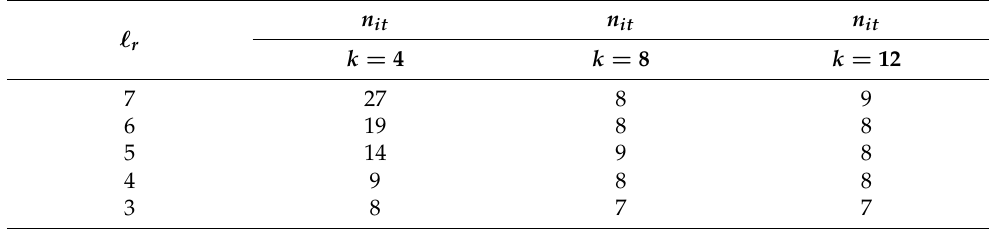
varying the degree k : (cid:96) r levels DD , k